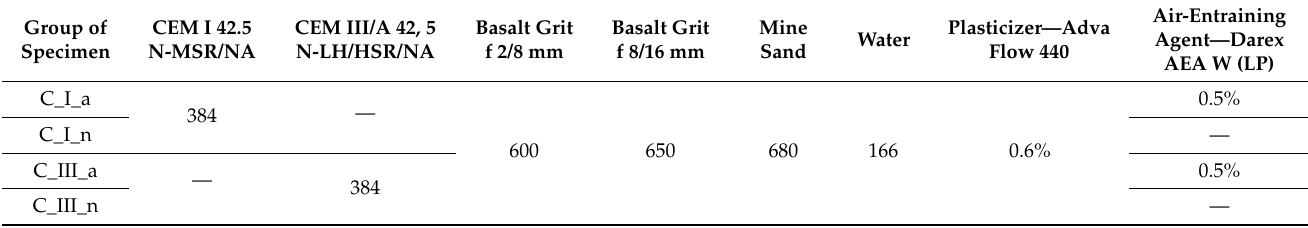
Table 1. Components of the concrete mix (kg/m 3 ).